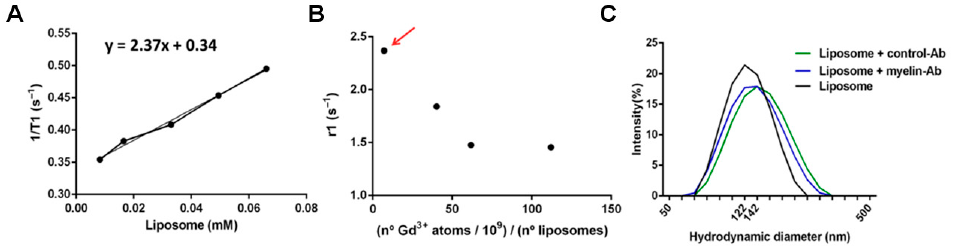
Figure 6. Characterization of liposomes. ( A ) Relaxation rate vs. concentration plots. ( B ) Longitudinal relaxivity vs. load of gadolinium plot, of prepared liposomes. ( C ) Hydrodynamic diameters of liposomes, as determined by DLS.